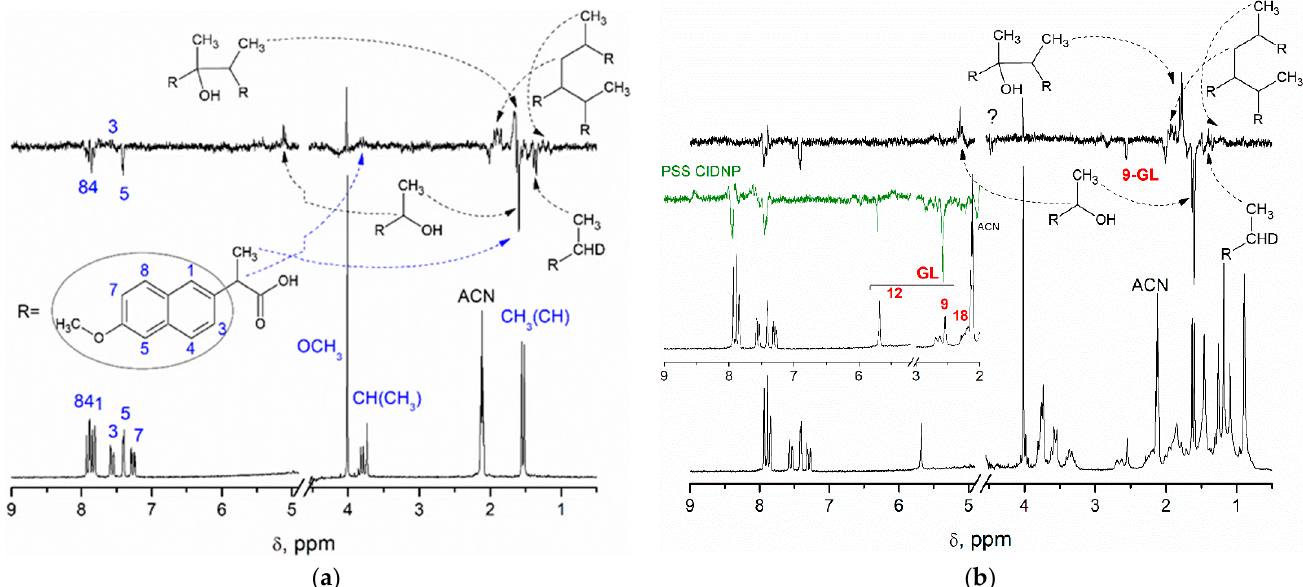
Figure 2. ( a ) 1 H NMR and TR ‐ CIDNP spectra of 4.3 mM NPX; ( b ) an equimolar mixture of NPX and GL (4.3 mM) in acetonitrile:water (1:2) solution; in insert: pseudo ‐ steady ‐ state (PSS) CIDNP spectra of NPX with GL under the same conditions (green). The delay time between the laser pulse and the NMR detection pulse is 0. Numbers designate the aromatic protons of NPX (blue) and GL (red). The analysis carried out according to Kaptein’s rules is presented in Table 1. Table 1. Analysis of CIDNP signs of NPX products.